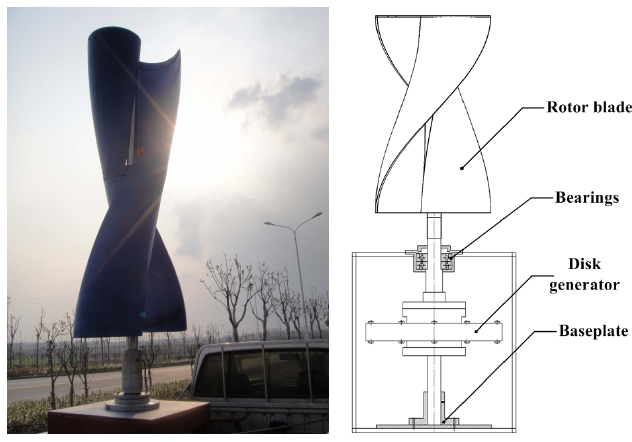
Figure 8. Tested vertical-axis spiral